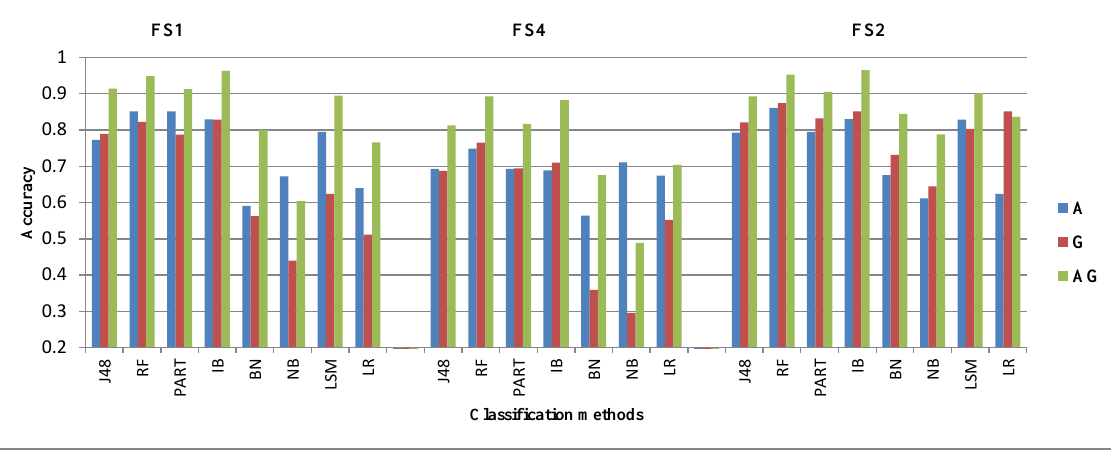
Figure 5. The recognition performance for the walking upstairs activity in Scenario